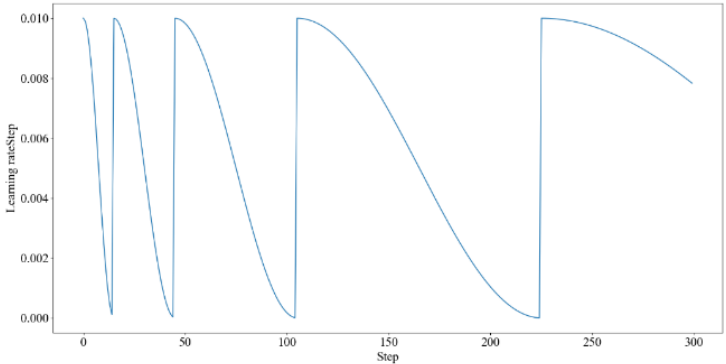
Figure 4. Learning rate curve of the cosine annealing with warm restarts.